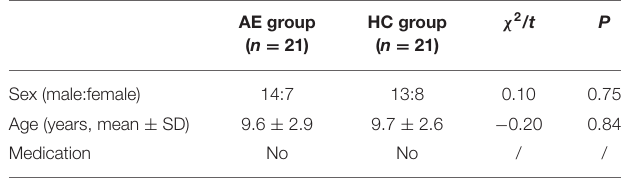
TABLE 1 | Demographic information of